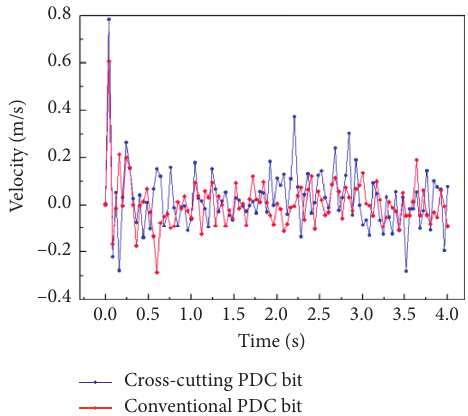
Figure 13: Velocity response along the drilling direction.